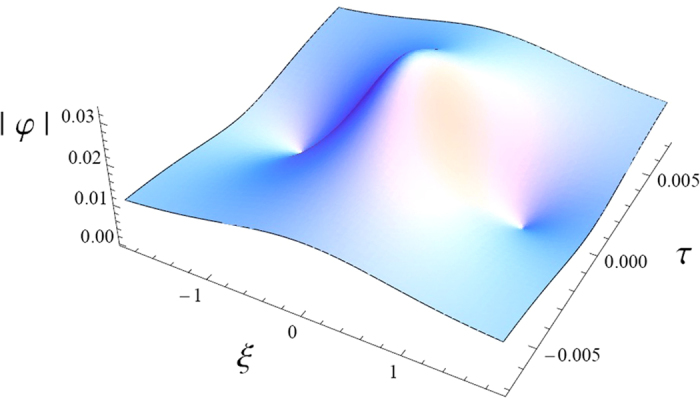
The rogue wave profile for carrier density ne0 = 1025 m−3 and k = 15.